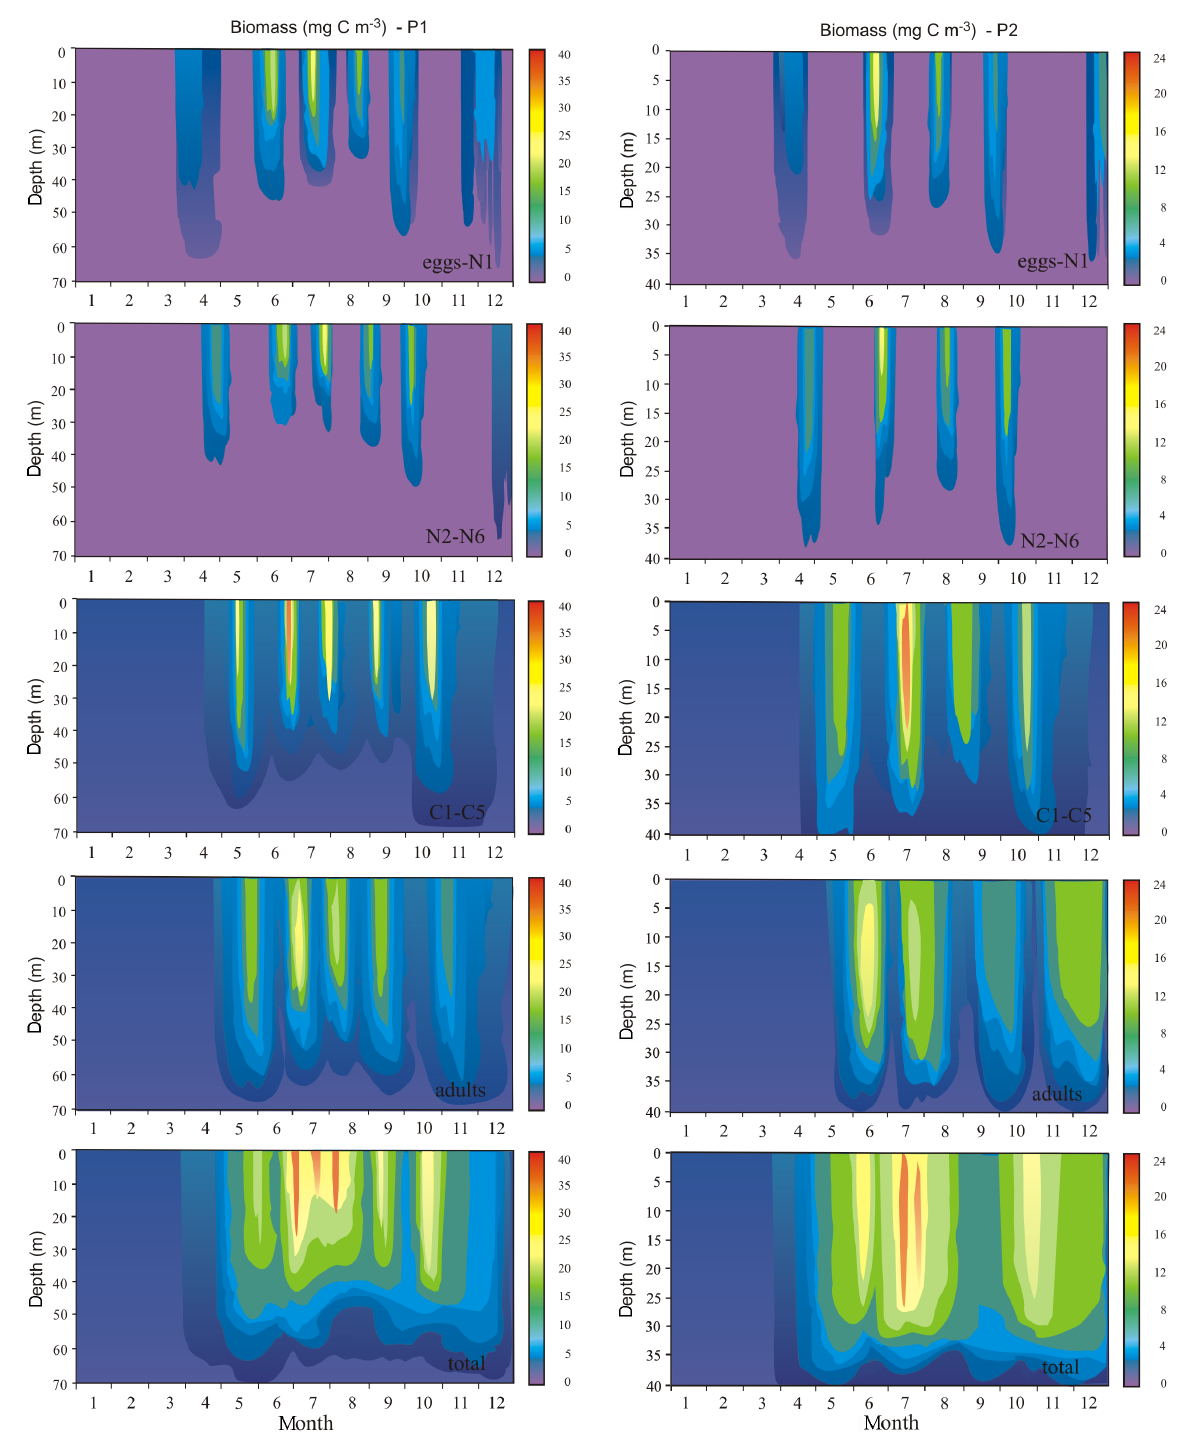
Fig. 6. Modelled vertical distributions of Temora longicornis development stages and the total biomass (mg C m –3 ) at stations P1 – Gda ń sk Deep and P2 – Gulf of Gda ń sk in